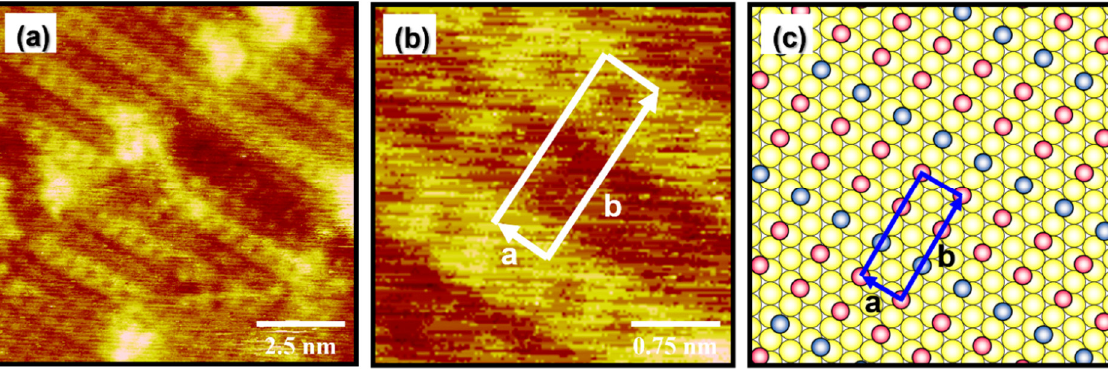
Figure 4. ( a , b ) Molecularly resolved STM images of EG2 SAMs on Au(111) formed at 348 K for 24 h via vapor deposition. ( c ) A proposed structural model of EG2 SAMs on Au(111). Scan sizes of STM images are 10 × 10 nm 2 ( a ) and 3 × 3 nm 2 ( b ).